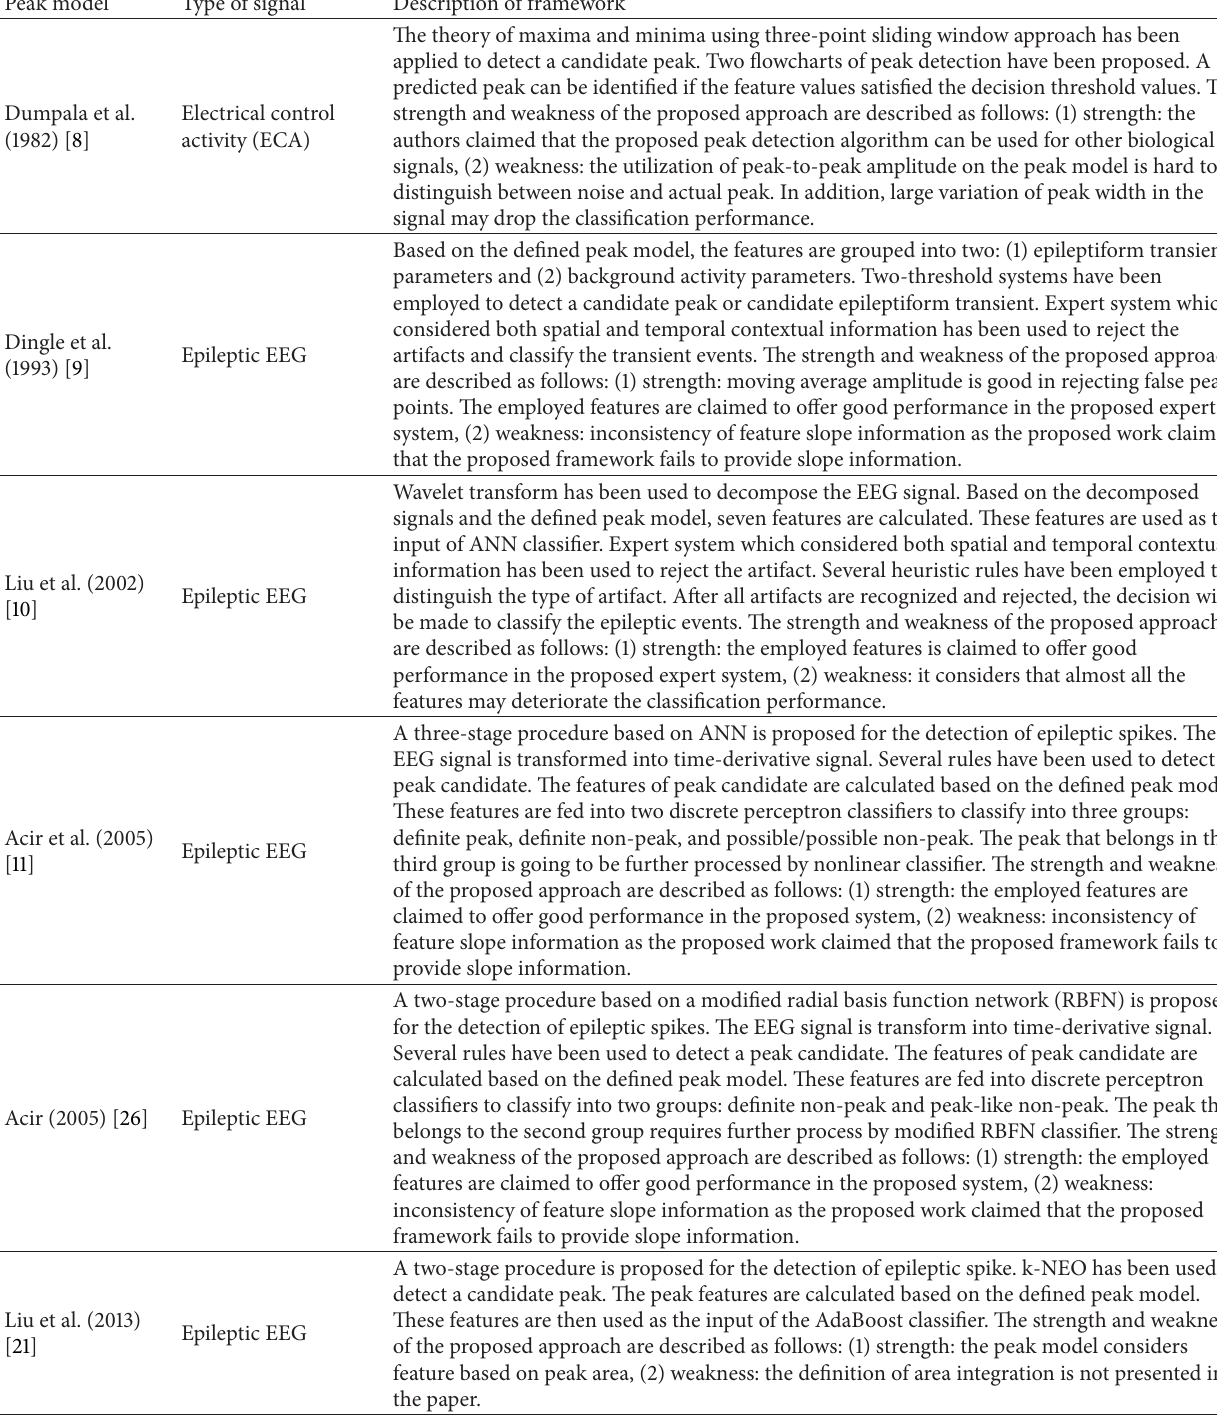
Table 1: Summary of different peak models on different style of